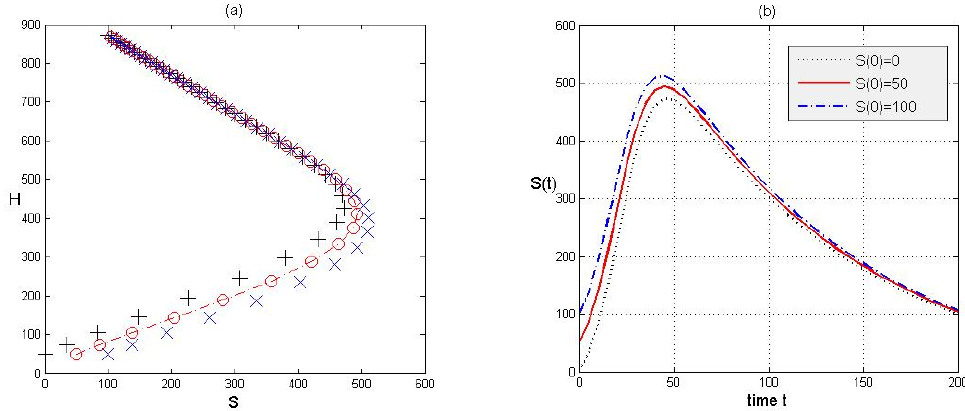
10 of 16 Figure 3. ( a ) The time series for spreaders and stiflers under 𝓡 𝟎 > 𝟏 ; ( b ) The time series for igno- rants and hibernators under 𝓡 𝟎 > 𝟏 . Figure 4a depicts that limit cycles (i.e., periodic orbits or cyclic chains) do not exist in the phase diagram of 𝑆 − 𝐻 , which is a necessary condition for the information’s repeated